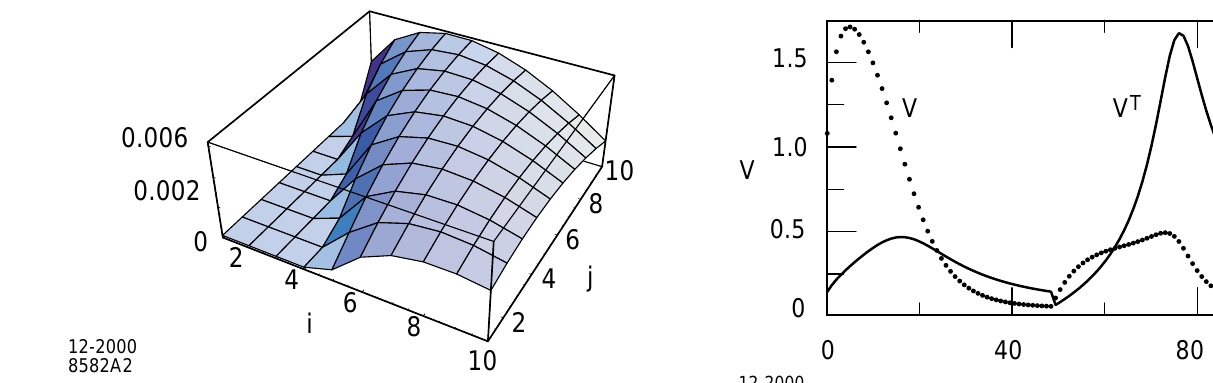
FIG. 2. (Color) The fastest growth rate of the radial modes for the resonance n (cid:1) 2 , l (cid:1) 2 1 vs beam currents. Bunch population (cid:1) N (cid:3) N 0 (cid:2) LER (cid:1) 1 1 0.2 (cid:1) i 2 1 (cid:2) , (cid:1) N (cid:3) N 0 (cid:2) HER (cid:1) 1 1 0.2 (cid:1) j 2 1 (cid:2) , (cid:1) i , j (cid:2) (cid:1) 1, . . . , 10 ; Q y LER (cid:1) 34.64 ; Q y HER (cid:1) 23.64 .